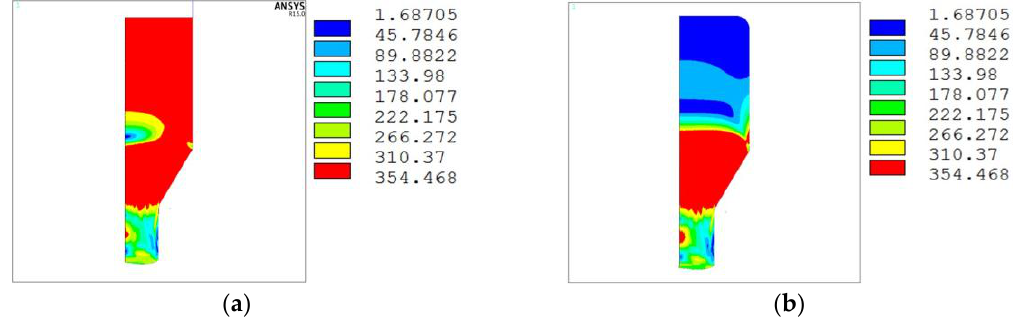
Figure 6. Von-Mises equivalent stress distribution of ( a ) displacement load and ( b ) pressure load.